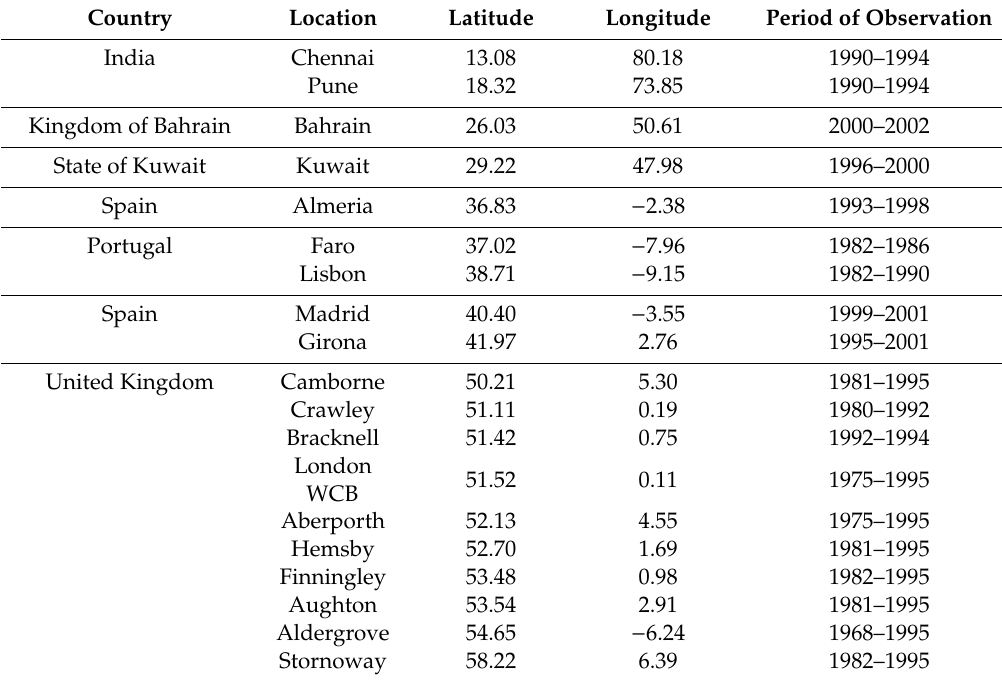
Table 4. Nineteen Worldwide Locations for the